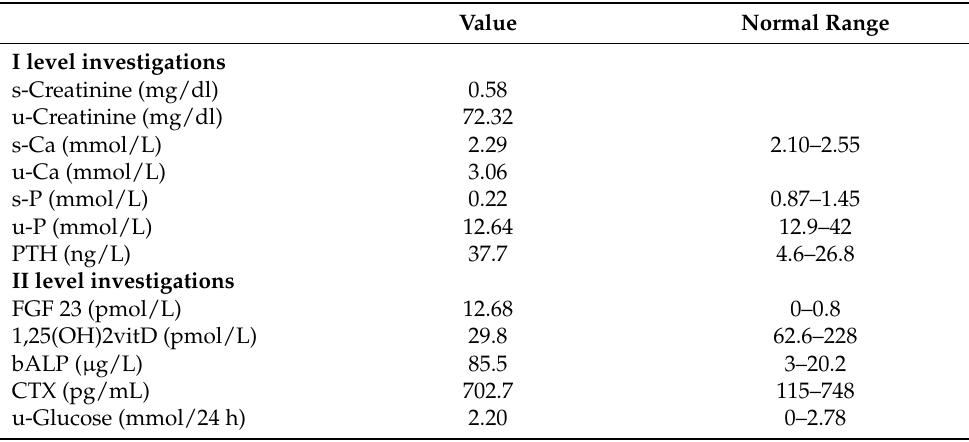
Table 1. Biochemical parameters at baseline.